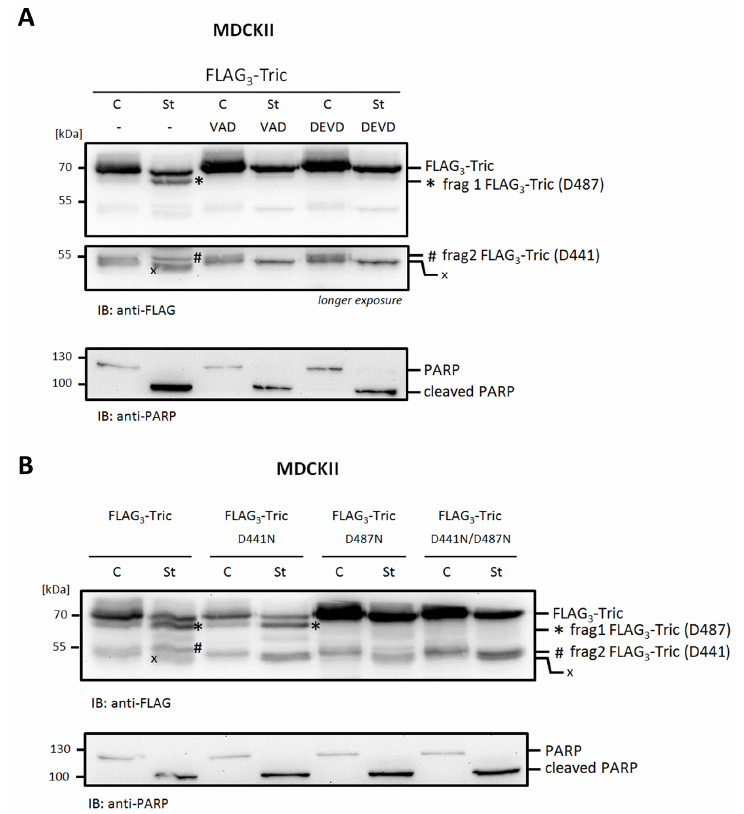
Figure 3. Caspase-3-mediated cleavage of FLAG 3 -tricellulin in MDCKII upon apoptosis